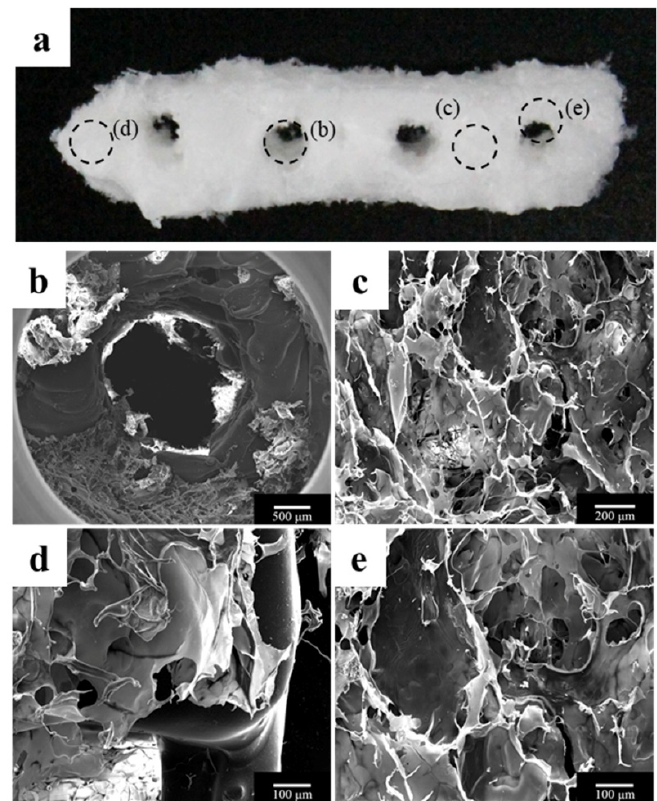
Figure 3. Morphology of the polycaprolactone (PCL) / β -tricalcium phosphate ( β -TCP) / bone decellularized extracellular matrix ( dECM) scaffold. ( a ) Visual image of the scaffold; ( b ) an implant through hole, which plays a role in guiding the implant fixture; and ( c – e ) bone dECM coated on the scaffold. Picture taken from Bae et al. [89] under the terms and conditions of the Creative